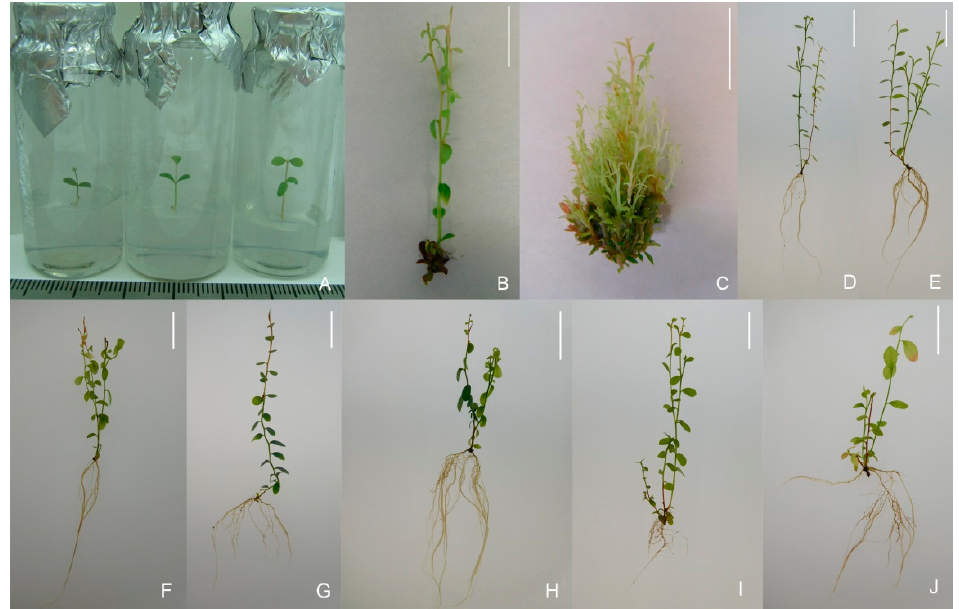
Figure 1. V. uliginosum × ( V. corymbosum × V. angustifolium ) hybrids in in vitro culture: ( A ) seedlings on 0.6% water agar; ( B , C ) microshoots of variant No. 4-1 and variant No. 4-5 on Anderson medium, supplemented 5 μМ 2iP; ( D ‒ J ) rooted plants of variant Nos. 1-1, 1-2, 1-5, 2-2, 4-2, 4-8, 7-9 on 1/2 Anderson medium. Bar: 1 cm.